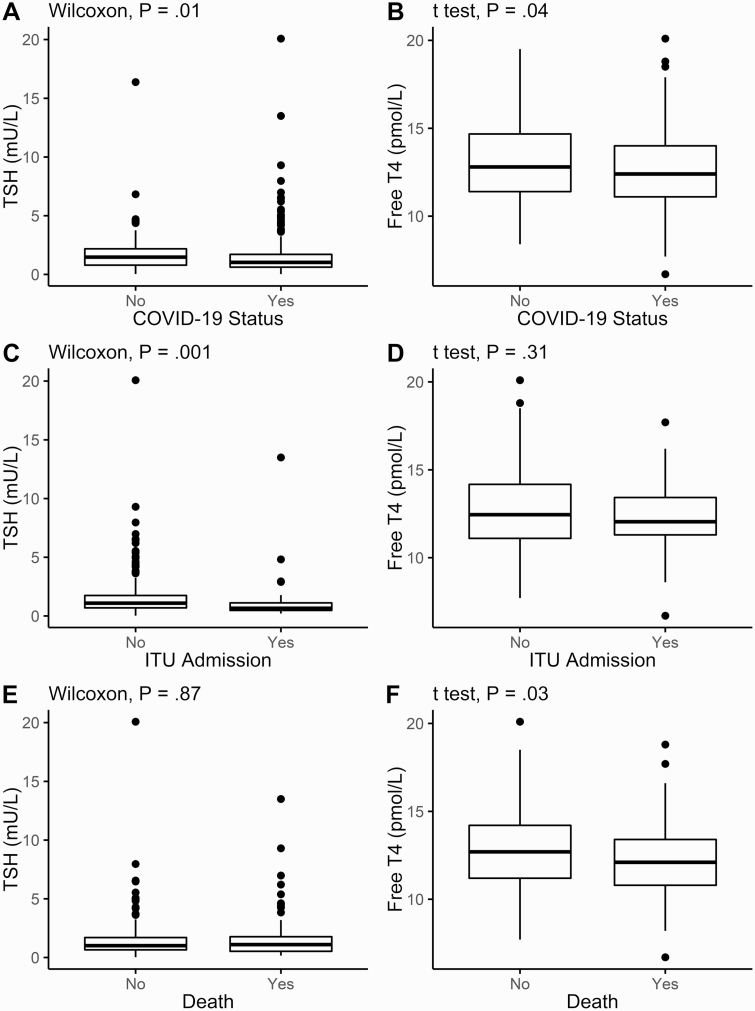
Thyrotropin (TSH) and free thyroxine (T4) on admission to the hospital. TSH and free T4 plotted with box indicating 25th and 75th percentiles, whiskers indicating fifth and 95th percentiles, and line in box indicating median, A and B, in all patients, classified by diagnosis of coronavirus disease 2019 (COVID-19); C and D, in COVID-19–positive patients, classified by admission to intensive therapy unit; E and F, in COVID-19–positive patients, classified by survival to May 8, 2020. Wilcoxon rank-sum tests used for comparison of TSH, unpaired t test for FT4.